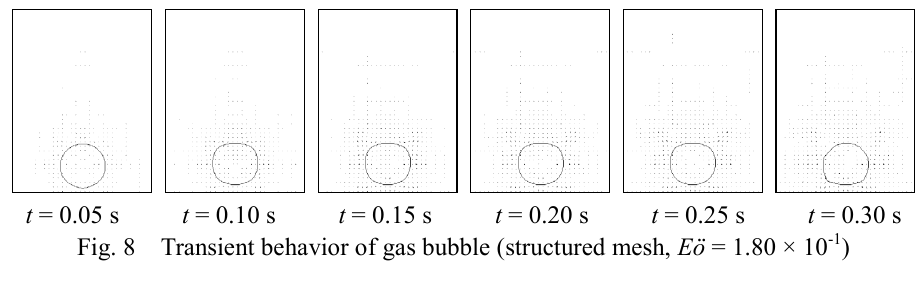
Transient behavior of gas bubble (structured mesh, Eö = 1.80 × 10 -1 )